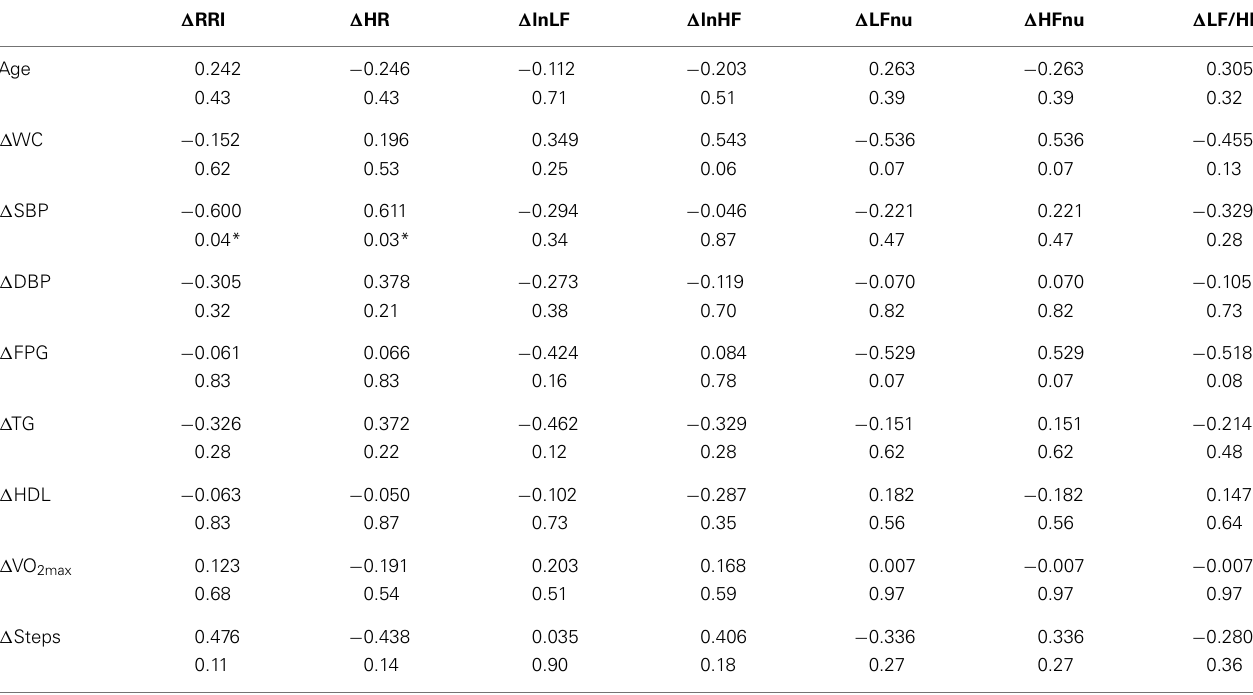
Table 3 | Correlation coefficients for changes in heart rate variability parameters and metabolic syndrome risk factors over the intervention